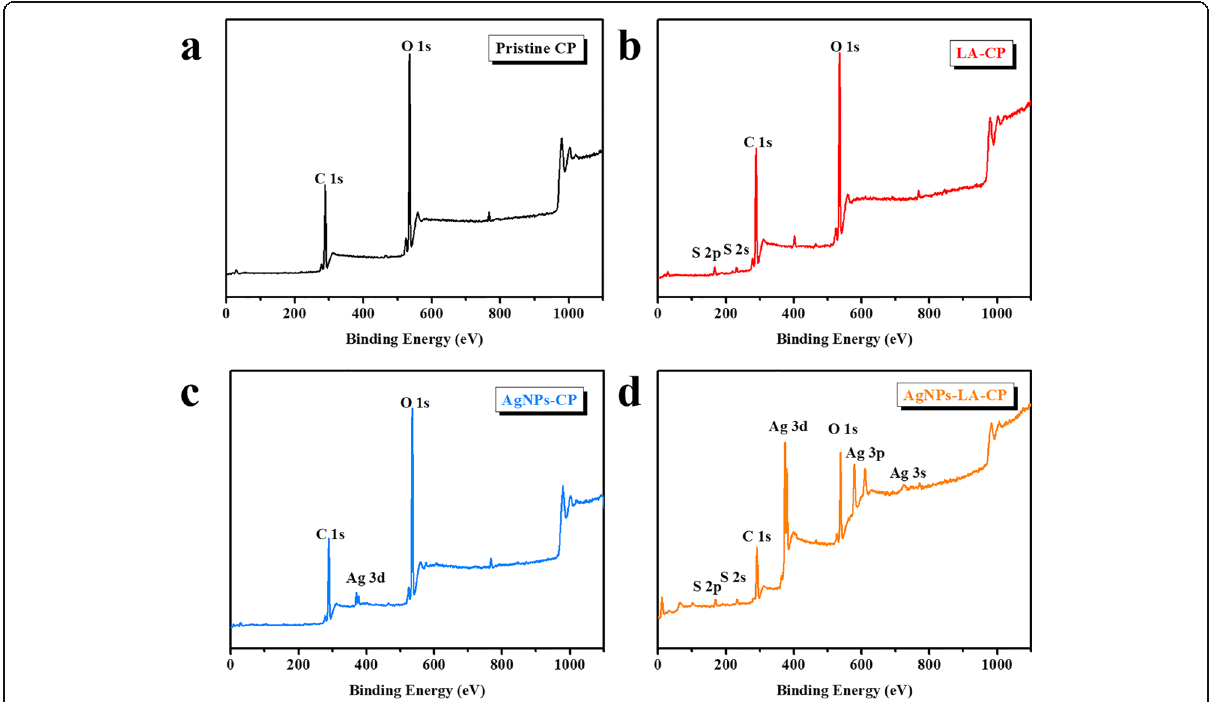
Fig. 4 XPS fully scanned spectra of a CP, b LA-CP, c GA@AgNPs-CP, and d GA@AgNPs-LA-CP